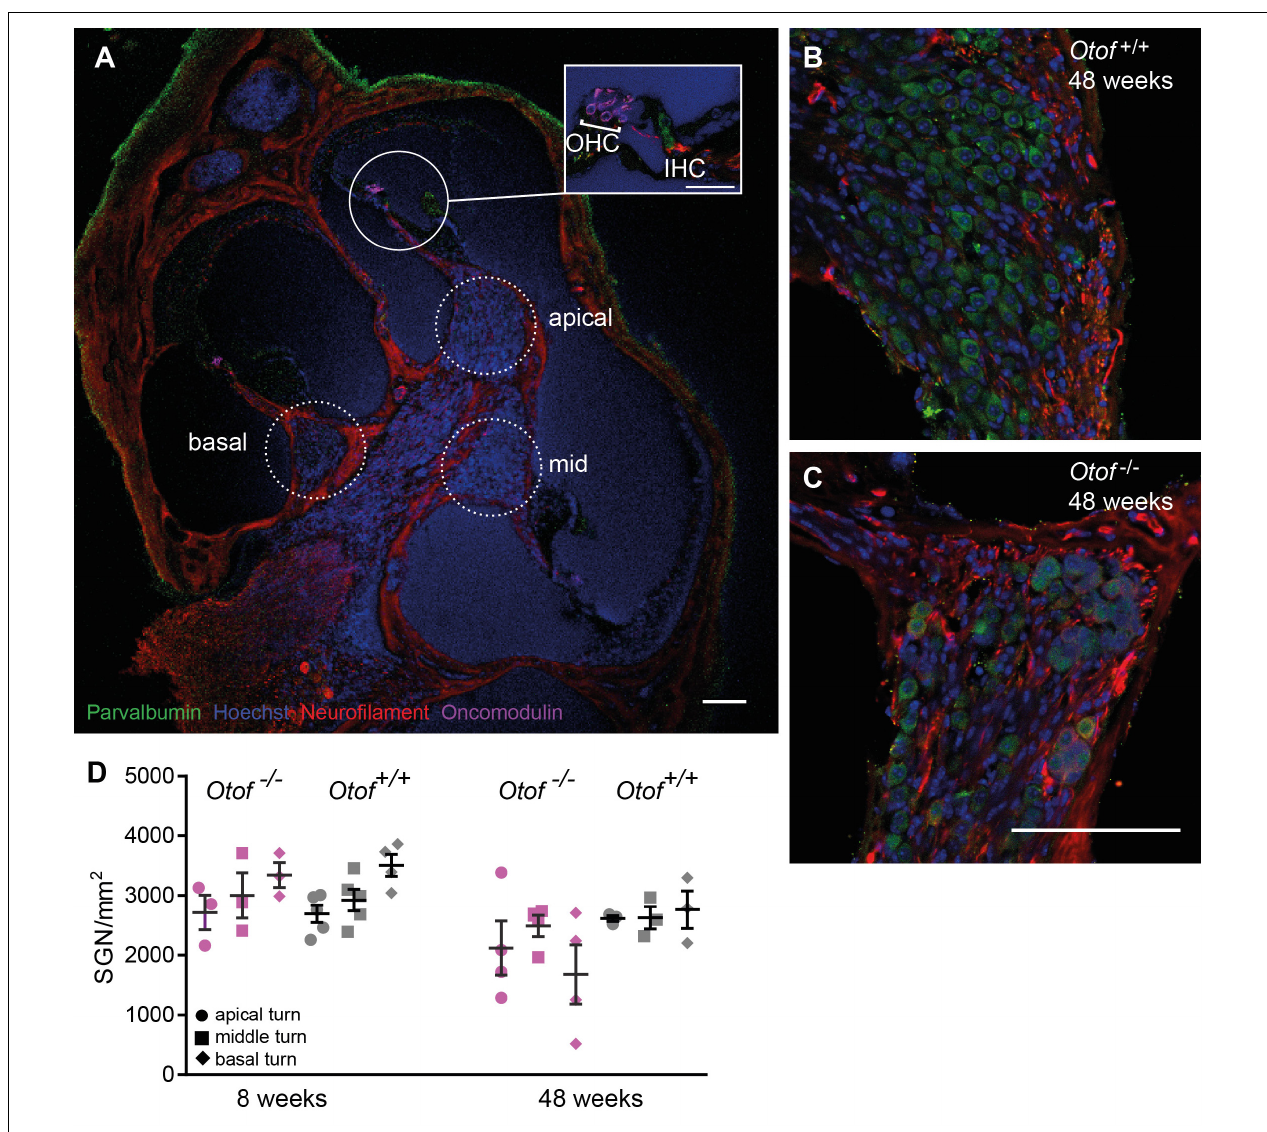
FIGURE 4 | Number of SGN cell bodies at 8 and 48 weeks of age. Cochleae were cryosectioned ( N = 3 to 5 cochleae, as indicated) and immunolabelled for parvalbumin, neurofilament, oncomodulin and nuclear stain (Hoechst). (A) Overview of a cochlear section (scale bar of inset: 30 µ m), Note that since imaging settings were optimized for the brightest fluorescence, which is for parvalbumin in hair cells, the weaker expression of parvalbumin is hardly visible in SGNs. (B,C) Higher magnification view of Rosenthal’s canal in the apical cochlea, (D) Cell bodies were counted in 20 µ m thick cryosections. SGN counts revealed a small but significant reduction in SGN numbers ( p = 0.038, 2way ANOVA genotype difference across tonotopic regions) in Otof − / − compared to Otof + / + cochleae at age 48 weeks. Scale bar, 100 µ